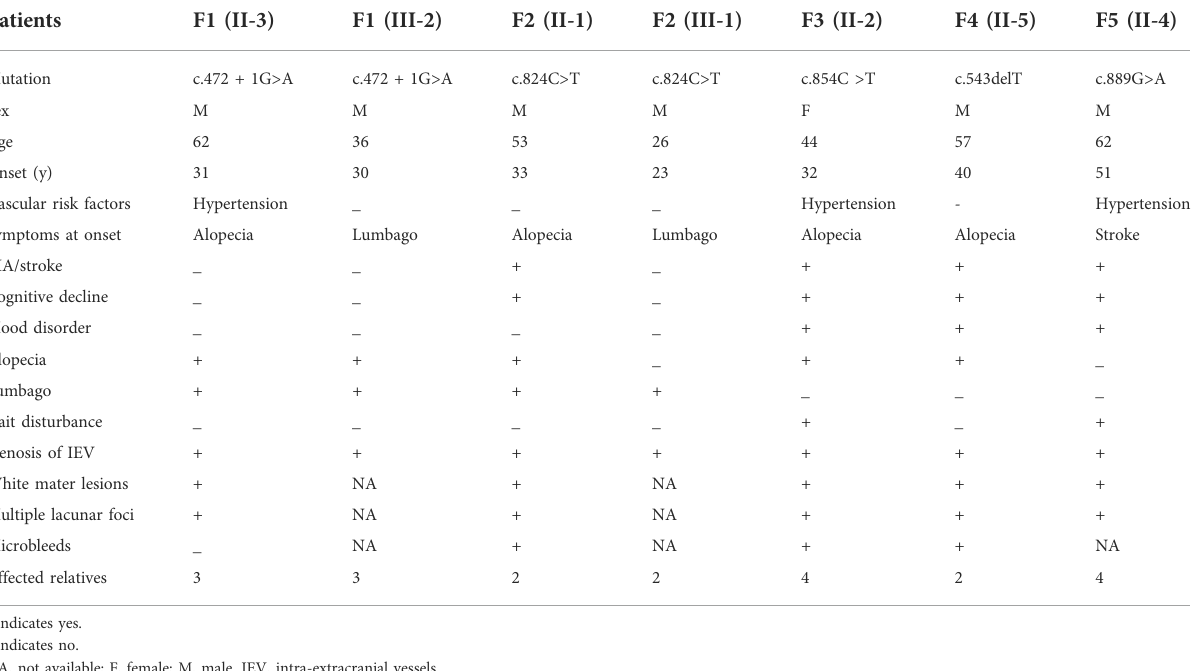
TABLE 2 Main clinical characteristics of the heterozygous HTRA1 pathogenic variant carriers.